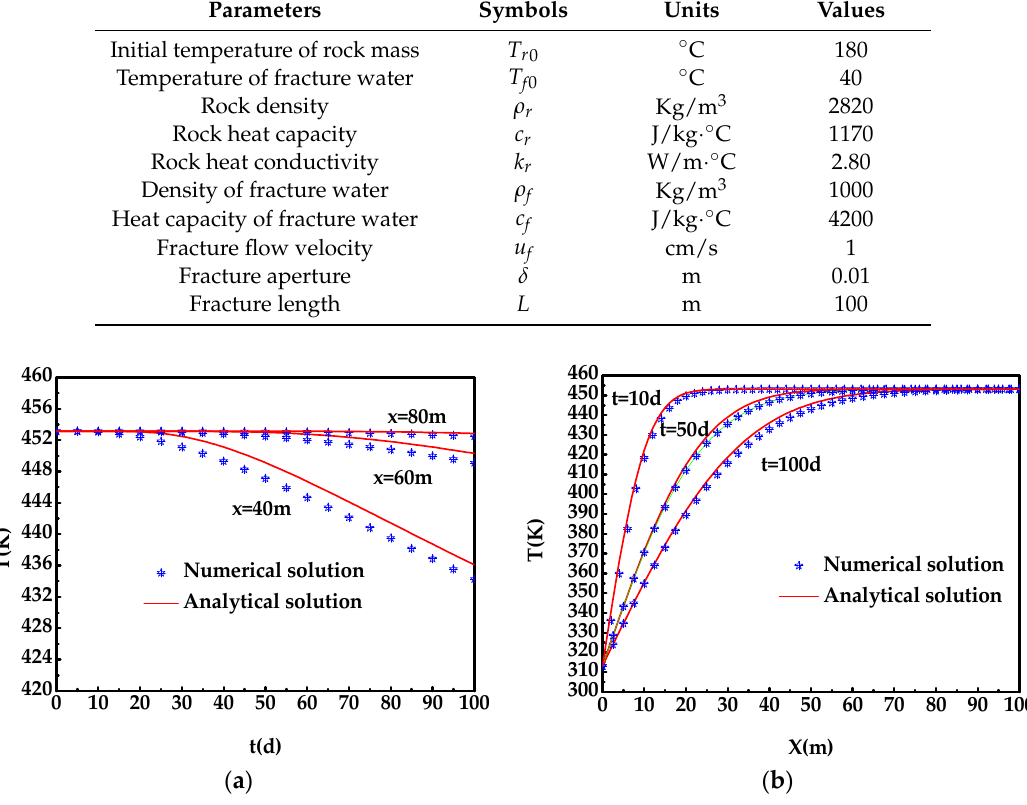
Figure 2. Heat transfer diagram of two-dimensional single fracture model. Table 2. Main material parameters of single fracture model. Table 2. Main material parameters of single fracture model.